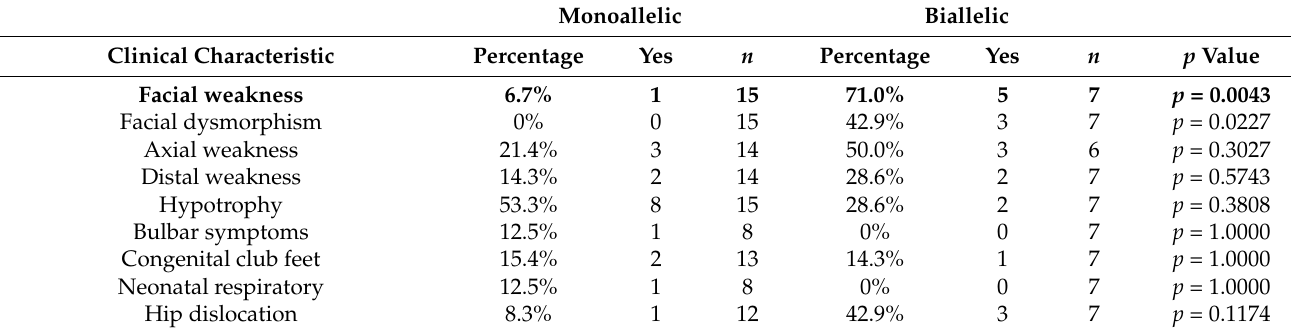
Table 4. Clinical characteristics in monoallelic and biallelic RYR1 variants.